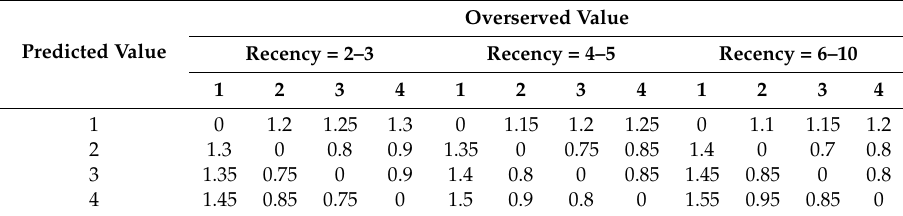
Table 6. Loss matrix for different binned recency values.